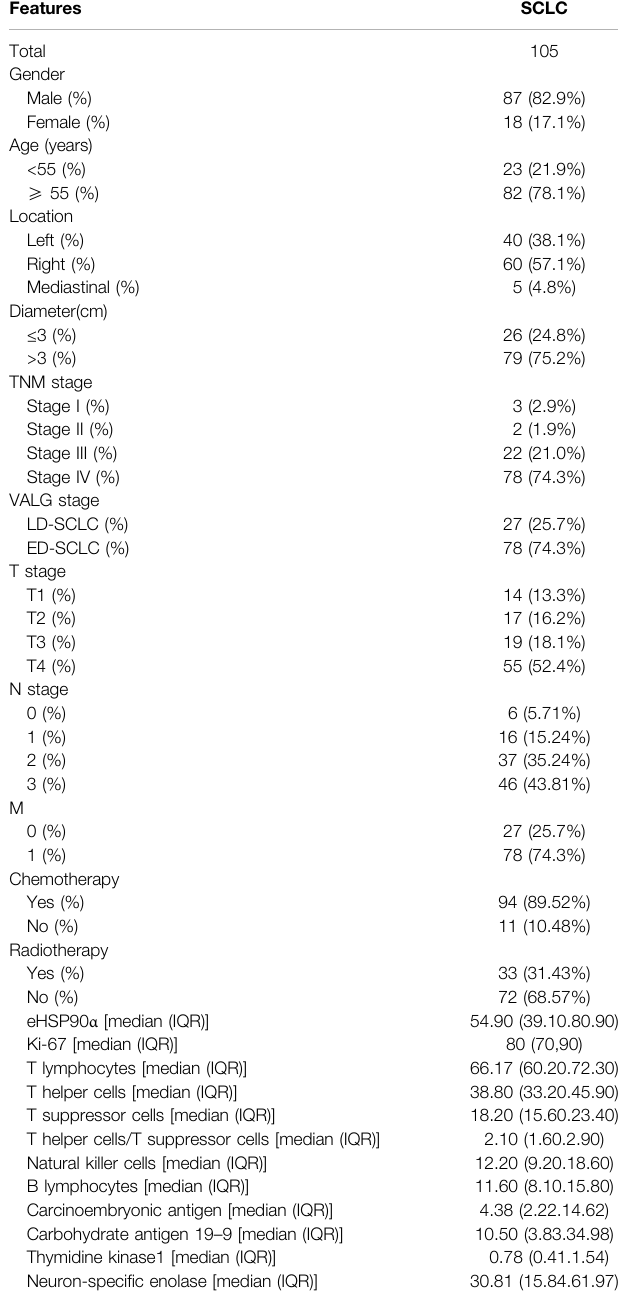
TABLE 1 | Patient characteristics and hematologic